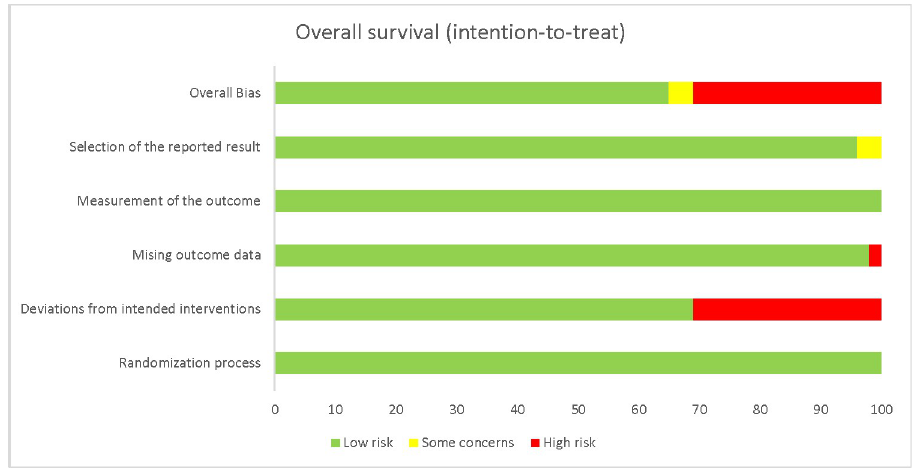
Fig 2. Risk of bias of the primary outcome, overall survival. Weighted graph showing the risk of bias according to each domain. Green = low risk. Yellow = some concerns. Red = high risk.